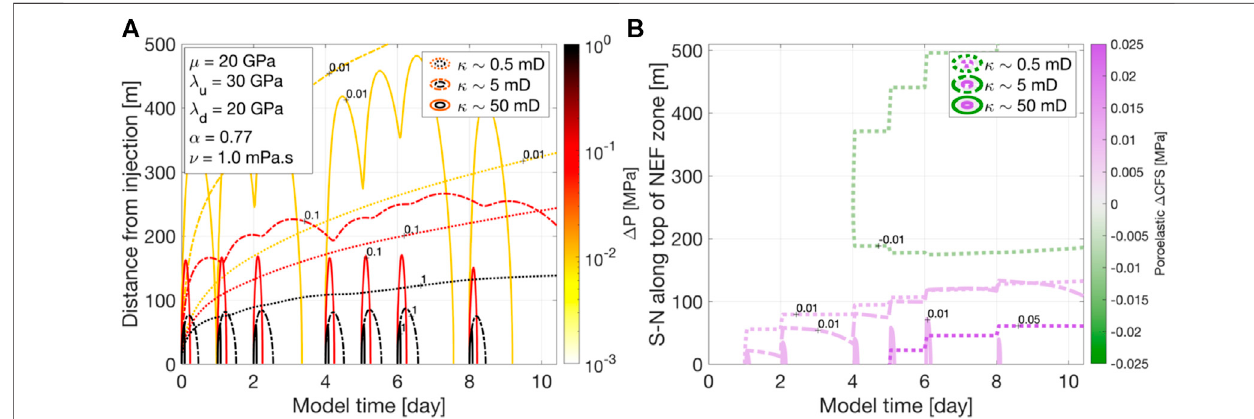
FIGURE 9 | Results of the poroelastic modeling for the PNR-2 operations, using the analytical solutions of Rudnicki (1986) for fl uid injection into a homogeneous poroelastic medium. (A) shows the change in the pore pressure Δ P with time and distance from the injection points at the end of the PNR-2 well. The poroelastic parametersusedareshowninsetanddescribedinthetext.Thecolorsdenotethemagnitudeofthe Δ Pcontour,andthelinestylesshowthethreedifferentpermeabilities used. With the PNR-1z NEF being around 250 m away from the injection, this simple model estimates a Δ P on the order of 0.1 MPa. (B) shows the poroelastic Coulomb stress change ( Δ CFS) resolved onto the geometry of the PNR-1z NEF. This shows how the Δ CFS value evolves with time for the line along the top of the fault zone, going south to north (see Figure 2 for the orientation of the inferred fault zone in 3D). The maximum poroelastic Δ CFS on the NEF is limited to around 0.01 MPa throughout PNR-2 operations. Poroelastic Δ CFS naturally increases markedly at the start of each injection period, and decays with time.